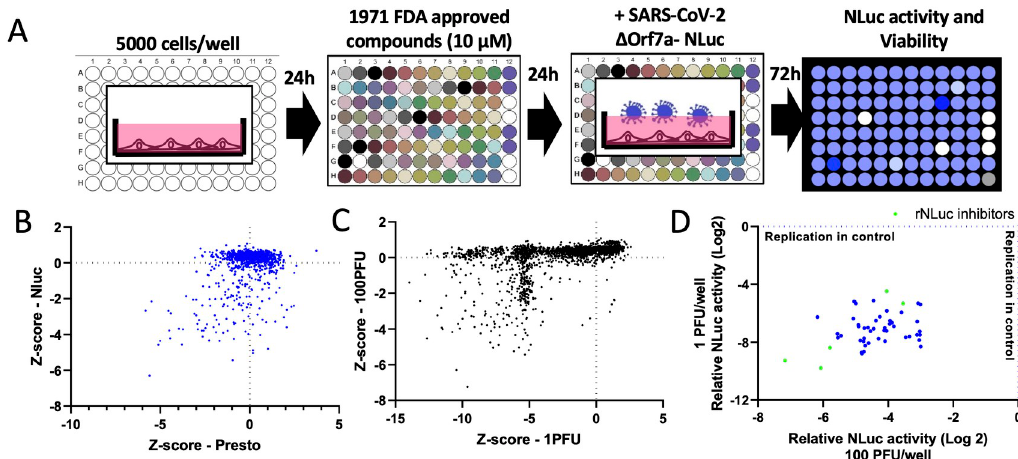
Fig 3. Screen of 1971 FDA-approved compounds to identify therapeutics that inhibit SARS-CoV-2- Δ Orf7a-NLuc virus replication. A) Schematic of the screening procedure used to assess whether FDA-approved compounds alter SARS-CoV-2 Δ Orf7a-NLuc virus replication. B) Scatterplot showing the effects of 1971 compounds on SARS-CoV-2 Δ Orf7a-NLuc replication and cell viability. C) Scatterplot showing the effects of 1971 compounds on SARS-CoV-2 Δ Orf7a-NLuc replication in replicate screens using 100 PFU or 1 PFU per well. The Z-score for luciferase activity is plotted. D) Scatterplot of 50 compounds that reduced NLuc activity in C. The luciferase activities relative to untreated controls (indicated by the blue dashed line) are shown. Highlighted in green are compounds that inhibit the NLuc enzyme